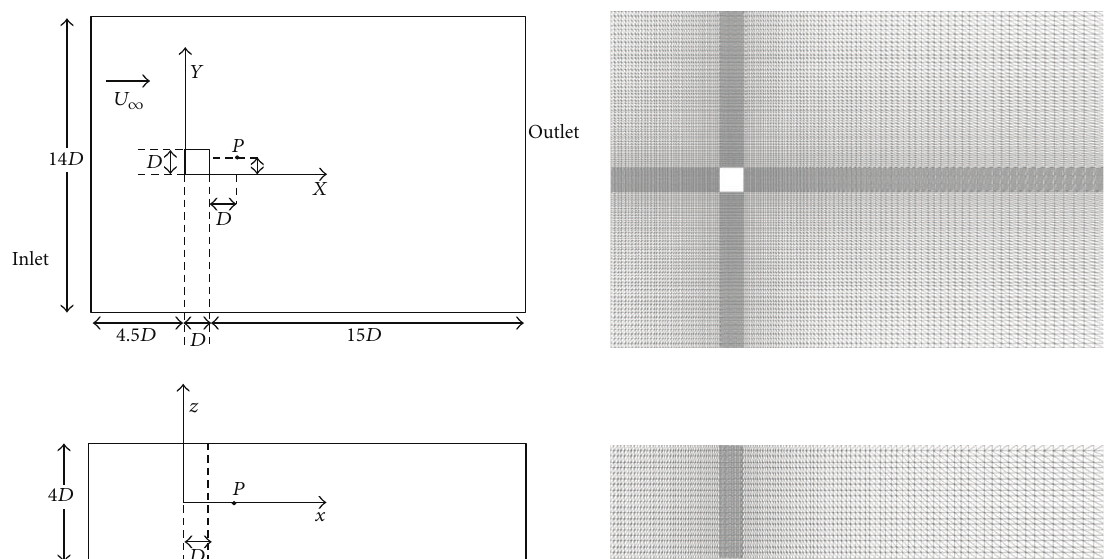
Figure 4: The geometry and mesh of the square cylinder validation case (Lyn et al. [15, 16]). Based on the rectangular side length 𝐷 (where 𝐷 = 0.04 m), a domain of size 21.5𝐷 × 14𝐷 × 4𝐷 was formed. Two different, nonuniform, hexagonal mesh densities were created; the first was composed of 130 × 120 × 20 cells ( 𝑦 + = 100 ), and the second was composed of 180 × 180 × 40 cells ( 𝑦 + = 30